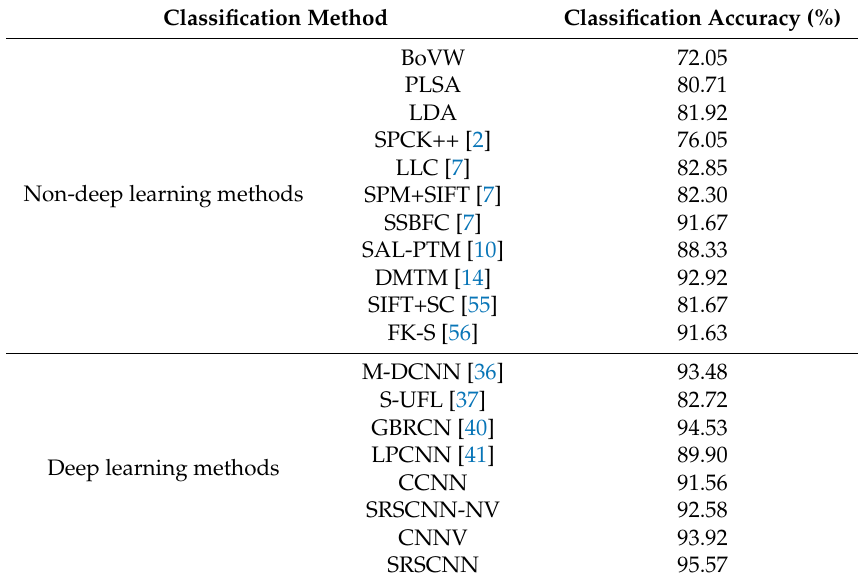
Table 2. Comparison with the previous reported accuracies with the UCM